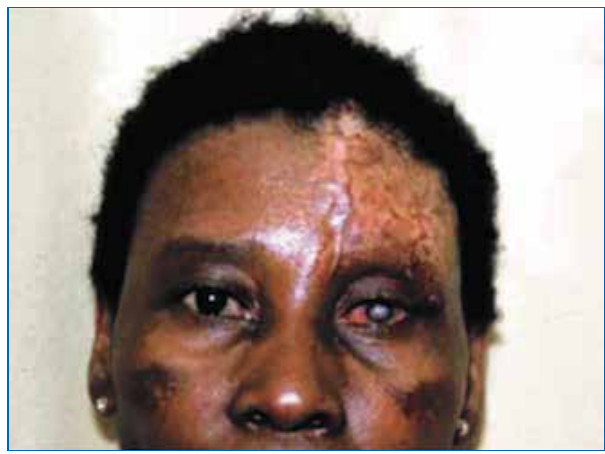
Figure 5: Permanent loss of vision due to ophthalmic